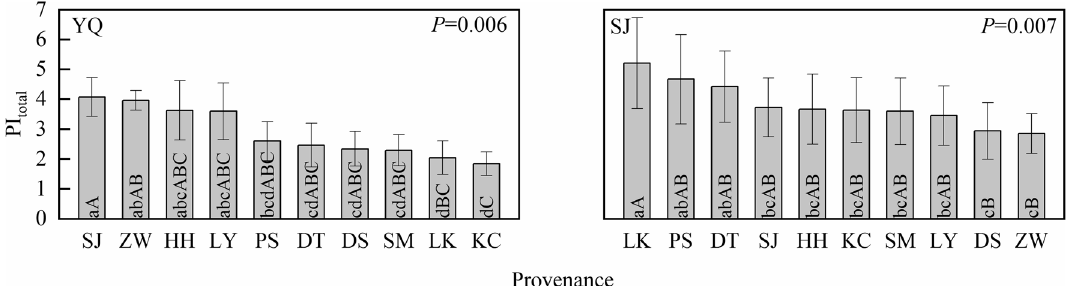
Figure 4. PI total analysis of Quercus liaotungensis seedlings between provenances. P -value indicates the differential significance of PI total between provenances in the same test site. YQ represents the Yangqu test site, and SJ represents the Sanjiao test site. Different lowercase letters indicate a significant difference at the 0.05 level, and uppercase letters indicate a significant difference at the 0.01 level.